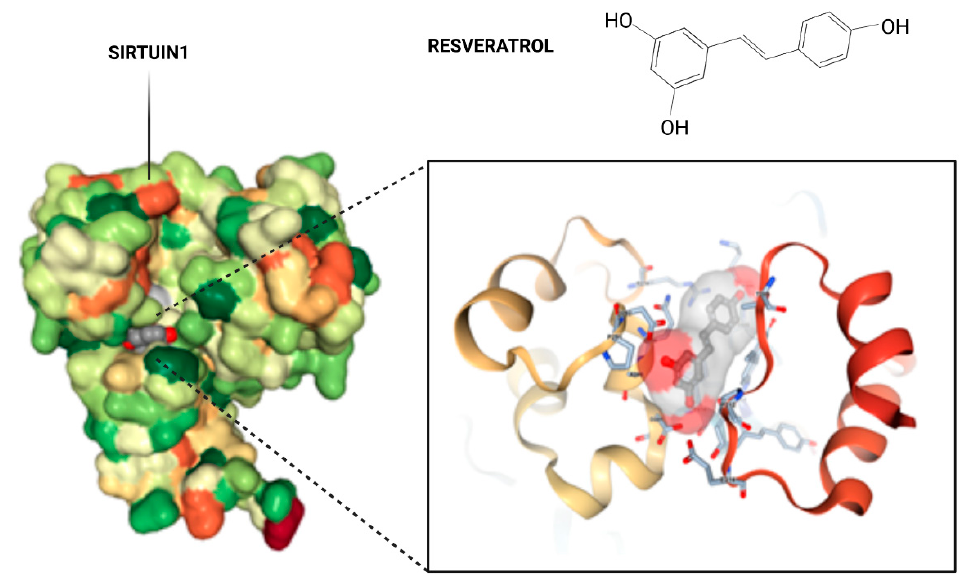
Figure 1. Crystal structure of Sirt1 in complex with resveratrol. The overall structure of SIRT1 with the protein domains and the catalytical core of the protein in magnification in amino acid structure binding to resveratrol. A pair of SIRT1 residues involved in interdomain interactions are shown in a stick model, with hydrogen bonds.